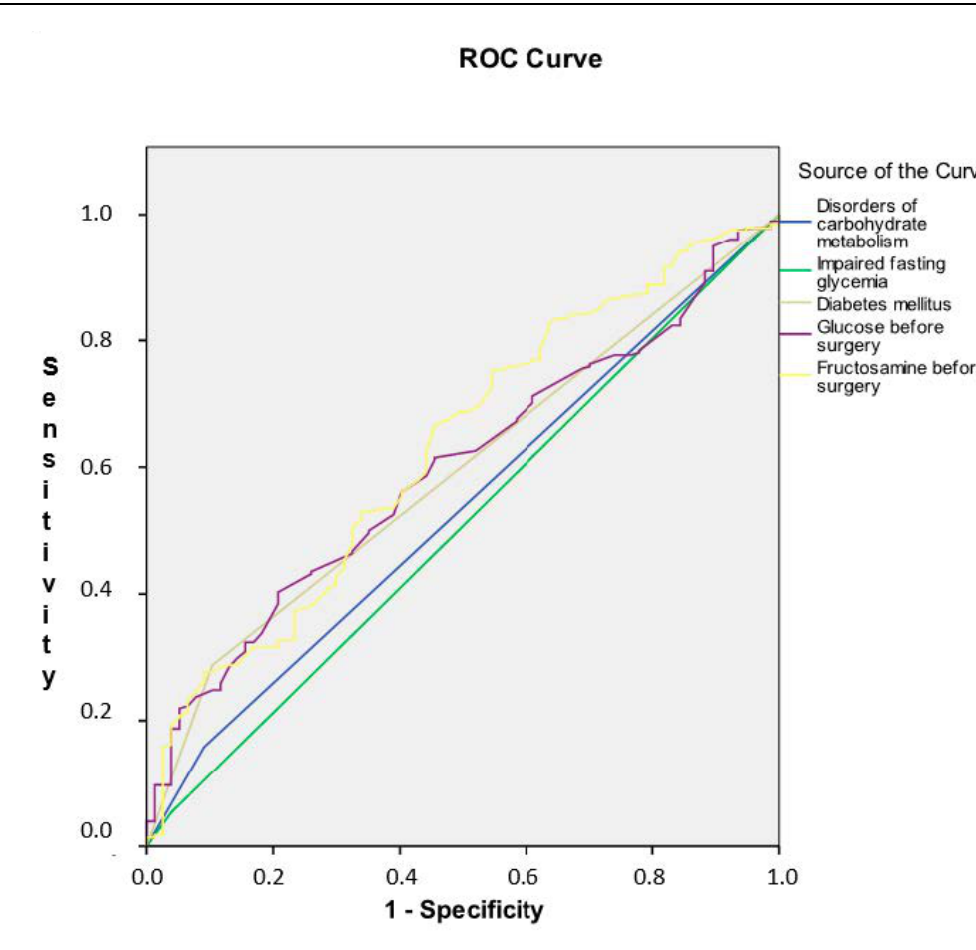
Figure 5. Receiver operating characteristic curve analysis. Performance of carbohydrate